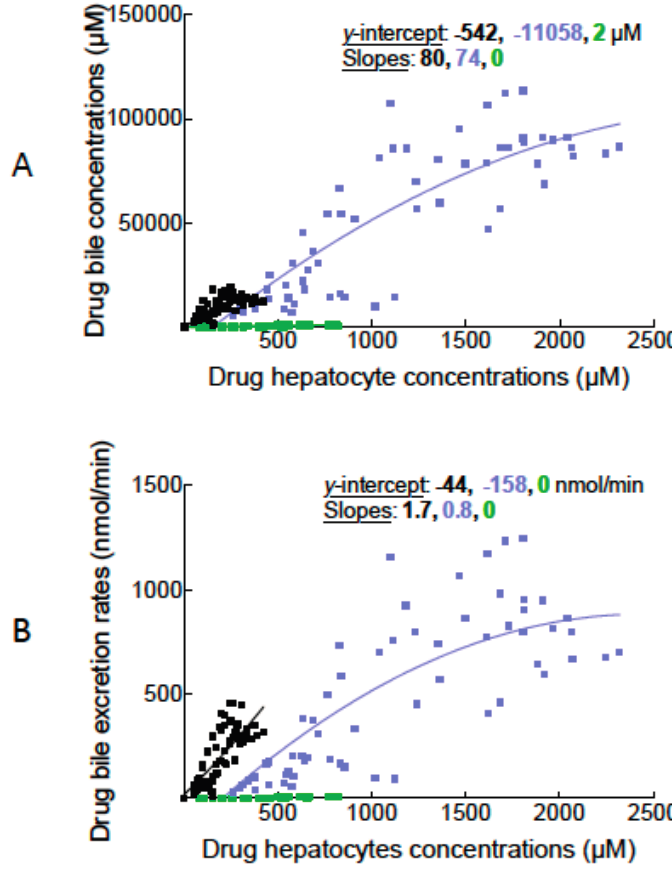
Figure 3. Plots between drug hepatocyte concentrations ( x -axis) and drug bile concentrations ( y -axis) ( A ) or drug bile excretion rates ( y -axis) ( B ). The three experimental groups are described in Figure 1. BOPTA (black squares, n = 5); BOPTA in Mrp2-deficient livers (green squares, n = 3); MEB (blue squares, n = 5).